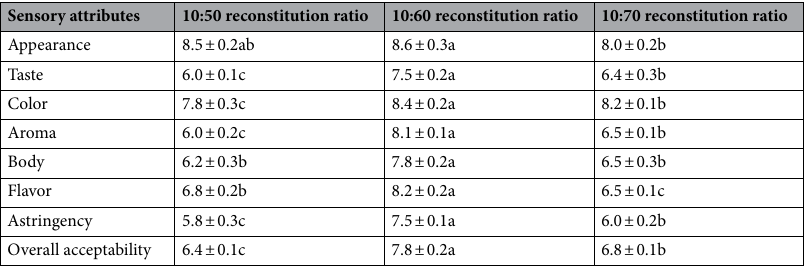
Table 2. Sensory evaluation of different rehydration volumes of water for lactic acid bacterial fermentation of RW-dried Kanji powder.